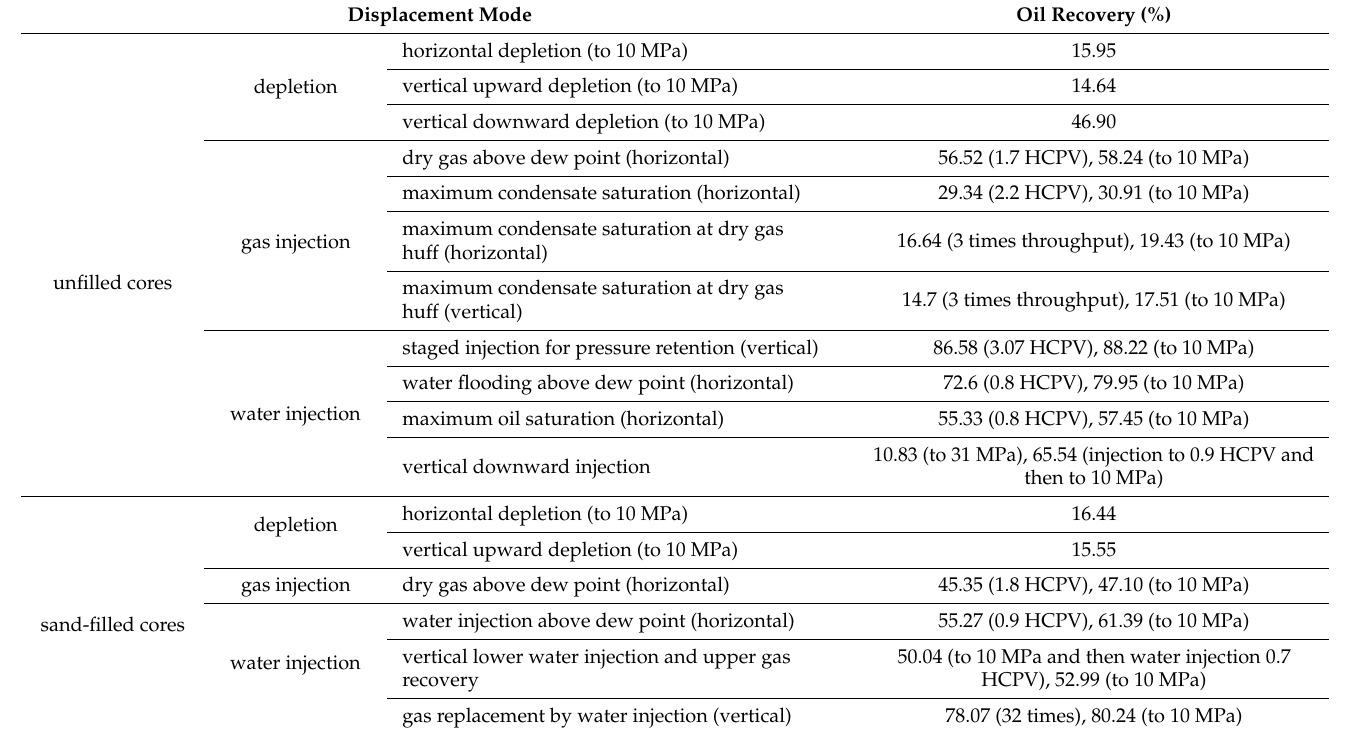
Table 1. The results from simulation experiments in cave-type